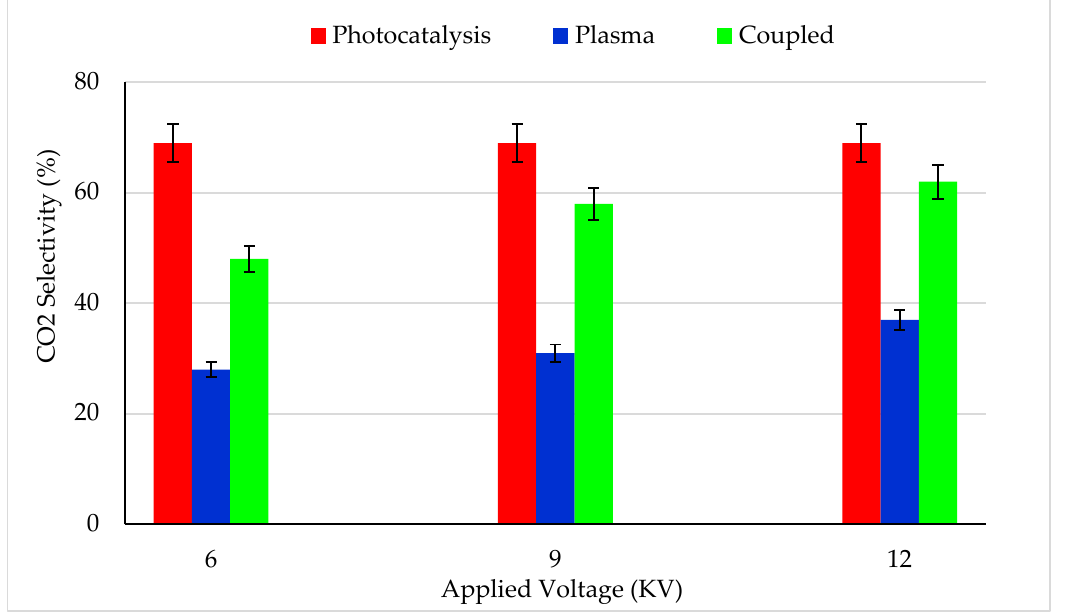
Figure 4. CO 2 selectivity for (i) photocatalysis, (ii) plasma–catalysis and (iii) Photocatalysis–plasma– catalysis combined process. CB inlet concentration: 13 mg/m 3 , Flow rate: 0.25 m 3 /h, RH: 5%, Temperature: 20 °C, Plasma applied frequency: 50 Hz.